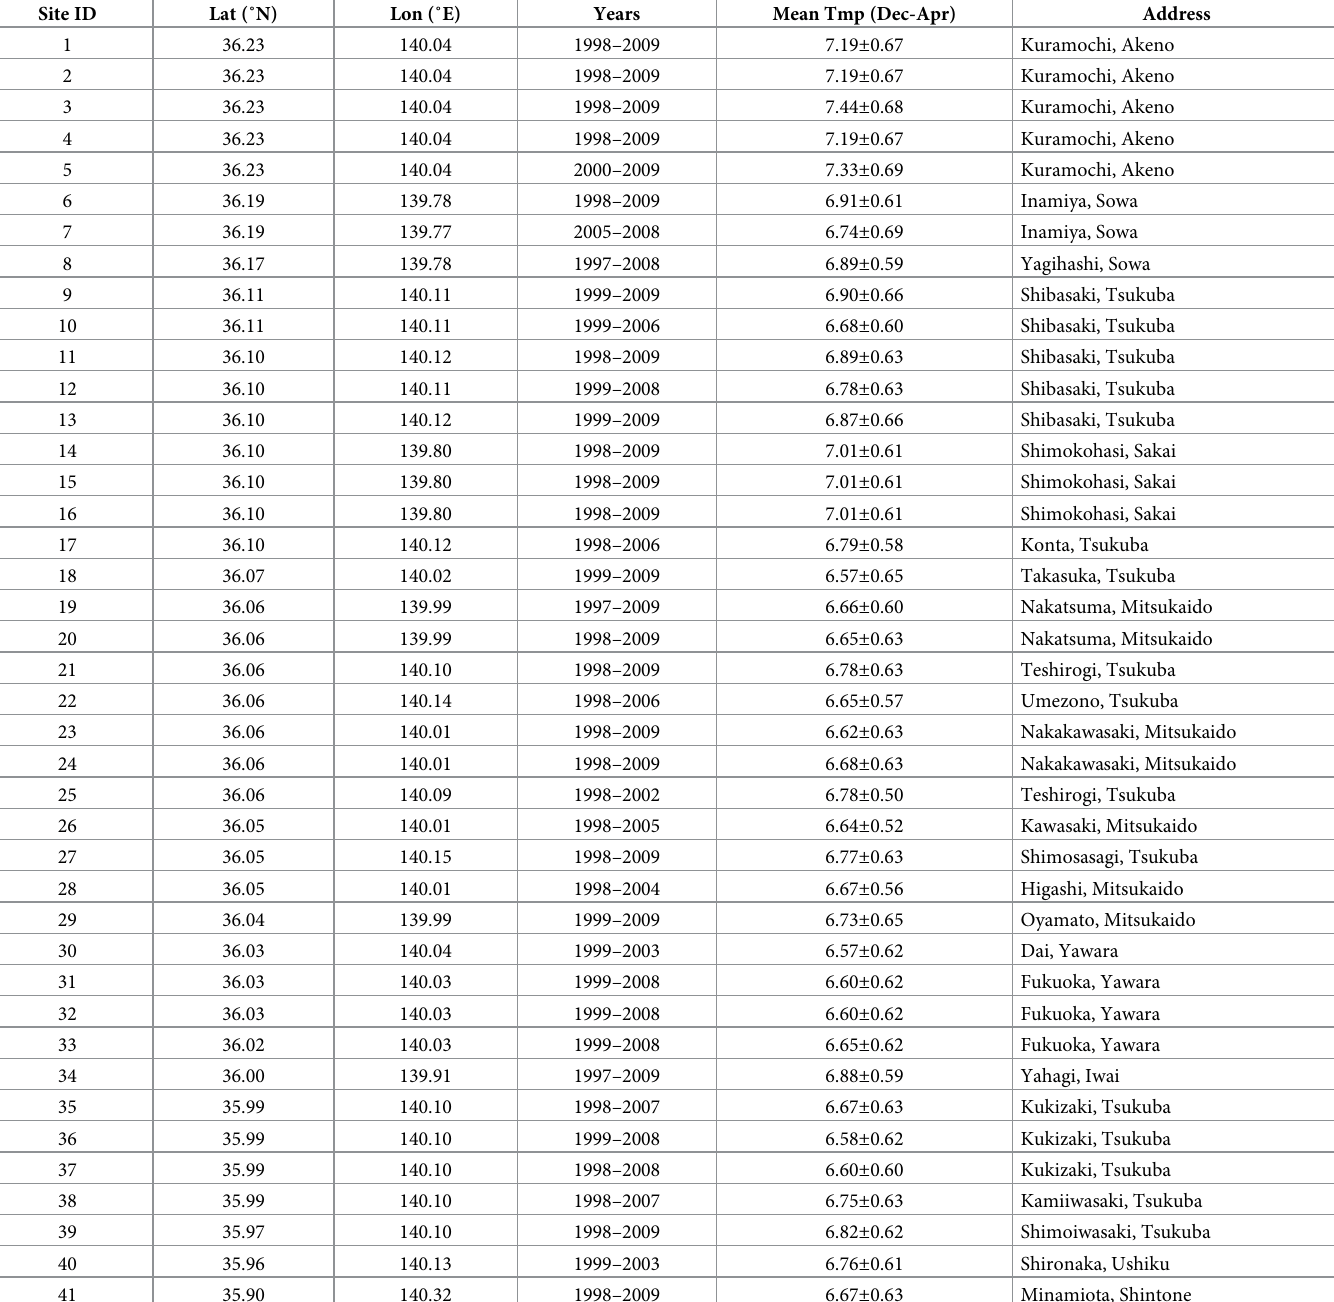
Table 1. Geographical location (latitudes, longitudes, and address), observation year, and mean temperature ( ± standard deviation) of the 41 study sites during the winter wheat growing season